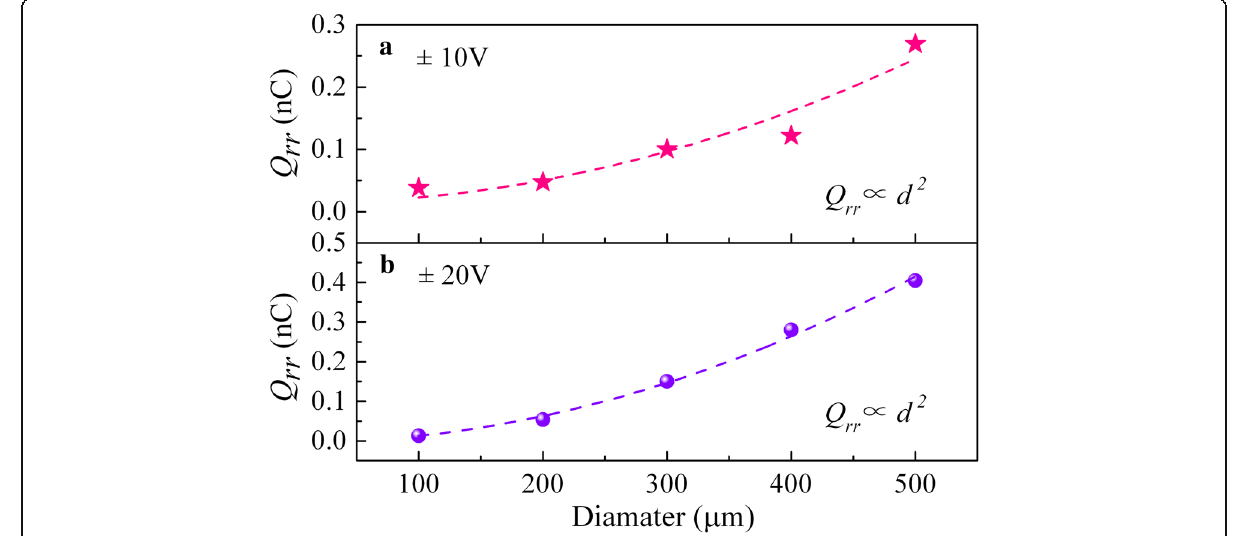
Fig. 6 Reverse recovery charge Q rr versus electrode diameter d